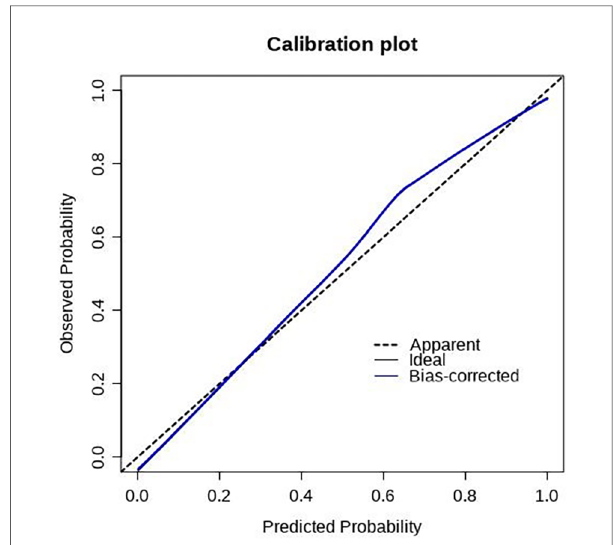
FIGURE 6 Calibration plot of the training set. The predictive models had good calibration with a mean error of 0.03 in the training set.